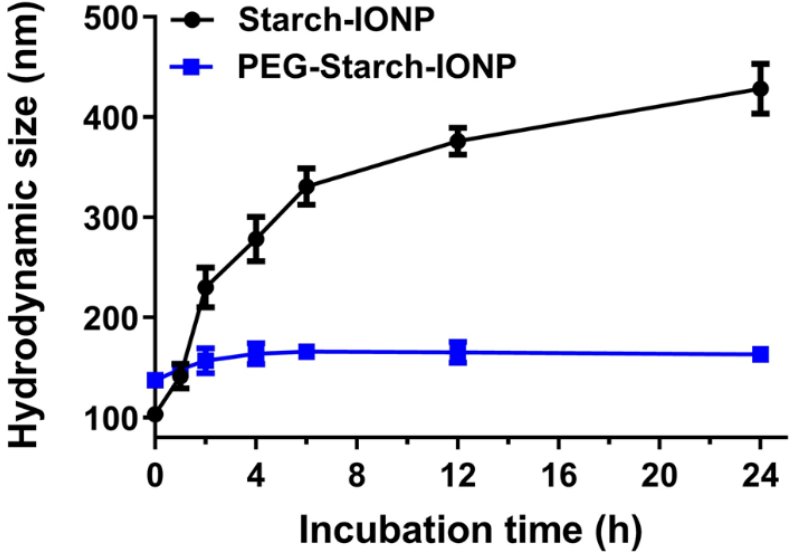
Figure 5. Size stability of nanoparticles. Compared with starch–IONPs, PEG–starch–IONPs could stably maintain their sizes for 24 h.